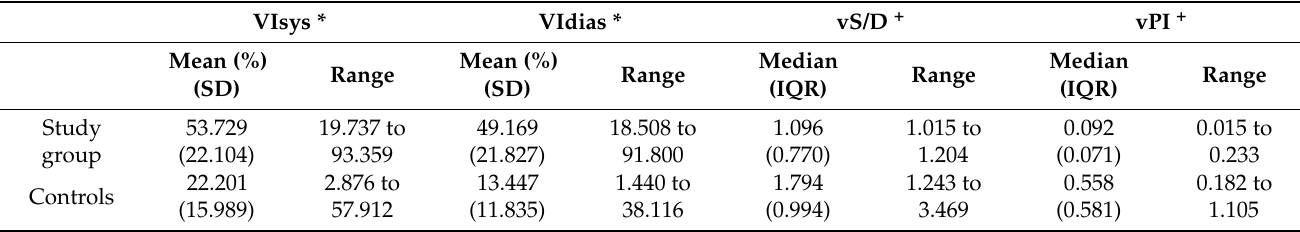
Table 1. Vascularization (3D) index in systole (VIsys) and diastole (VIdias) and volumetric 4D indices vS/D and vPI, in study and control group.